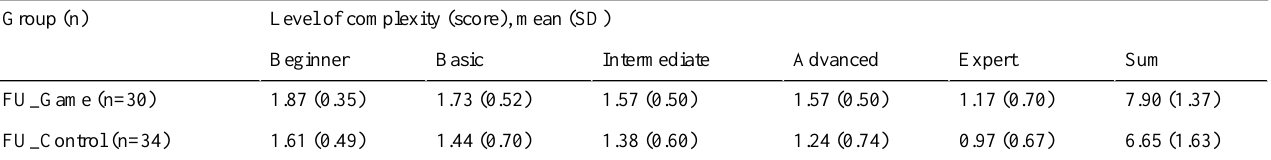
Table 4. Descriptive results from study 2.